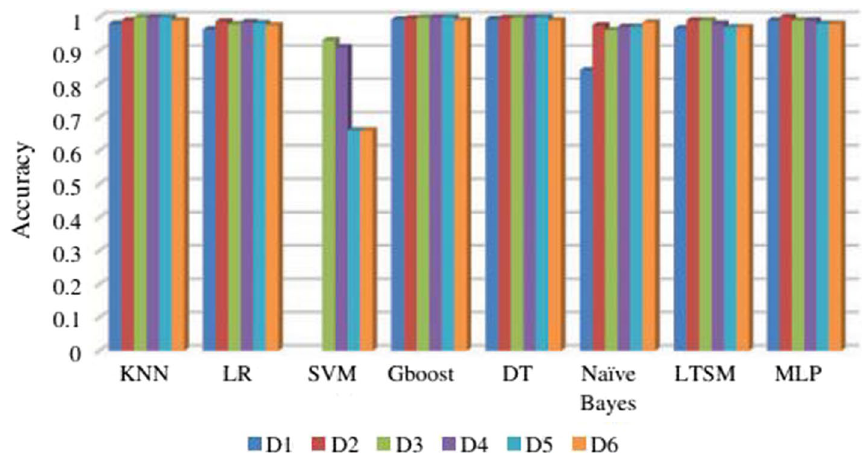
Fig. 1 Accuracy comparison between different datasets sizes and machine learning algorithms